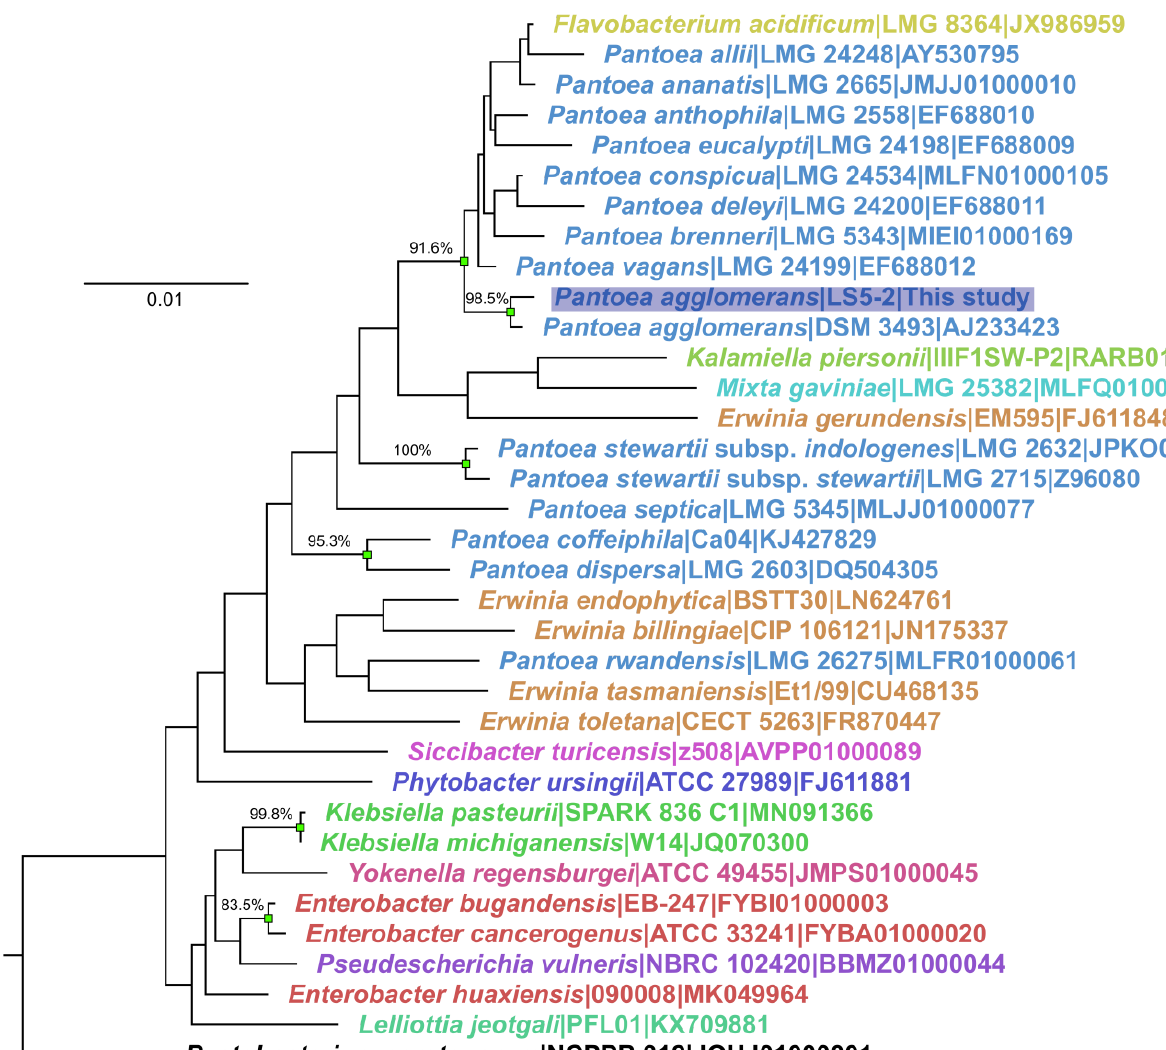
Figure 1. Neighbor-joining tree of 16S rRNA gene sequences of bacterial isolate LS5-2 and closely related bacterial species. The analysis involved 35 nucleotide sequences (16s rRNA gene sequences of P. agglomerans isolate LS5-2-host strain of the phages described within this study, 33 other closely related bacterial species, and Pectobacterium carotovorum as an outgroup for rooting). Tip labels correspond to the taxa and are in the format of “Species|Strain|Accession”; tip label colors correspond to different bacterial genera. The tip label of the sequence corresponding to the isolate LS5-2 is additionally highlighted in blue. The percentage of replicate trees in which the associated taxa clustered together in the bootstrap test (out of 1000 replicates) is indicated for branches having bootstrap support higher than or equal to 80%; such branches also have their distal nodes indicated by green rectangles. The evolutionary distances are in the number of base differences per site and the tree is drawn to scale. All positions with less than 90% site coverage were eliminated. That is, fewer than 10% alignment gaps, missing data, and ambiguous bases were allowed at any position. There were a total of 1346 positions in the final dataset.